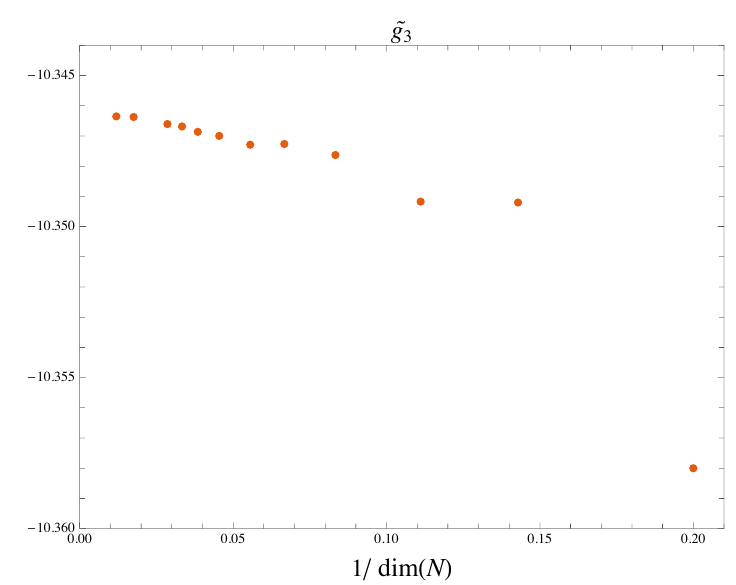
Figure 7. The ˜ g 3 lower bound vs. 1 / dim N , where dim N is the dimension of the number of null constraints accessed. Plotting with respect to 1 / (dim N ) 2 or different powers of 1 /n did not reveal any particularly compelling fitting function. The kink described in the next plot is situated at − 10 . 19 ≈ ˜ g . 3